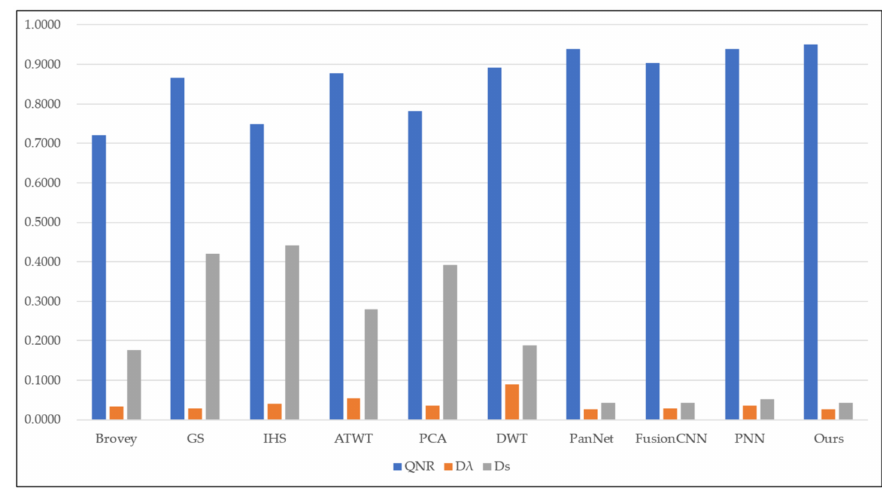
Figure 16. Histogram result of the fourth group of evaluation